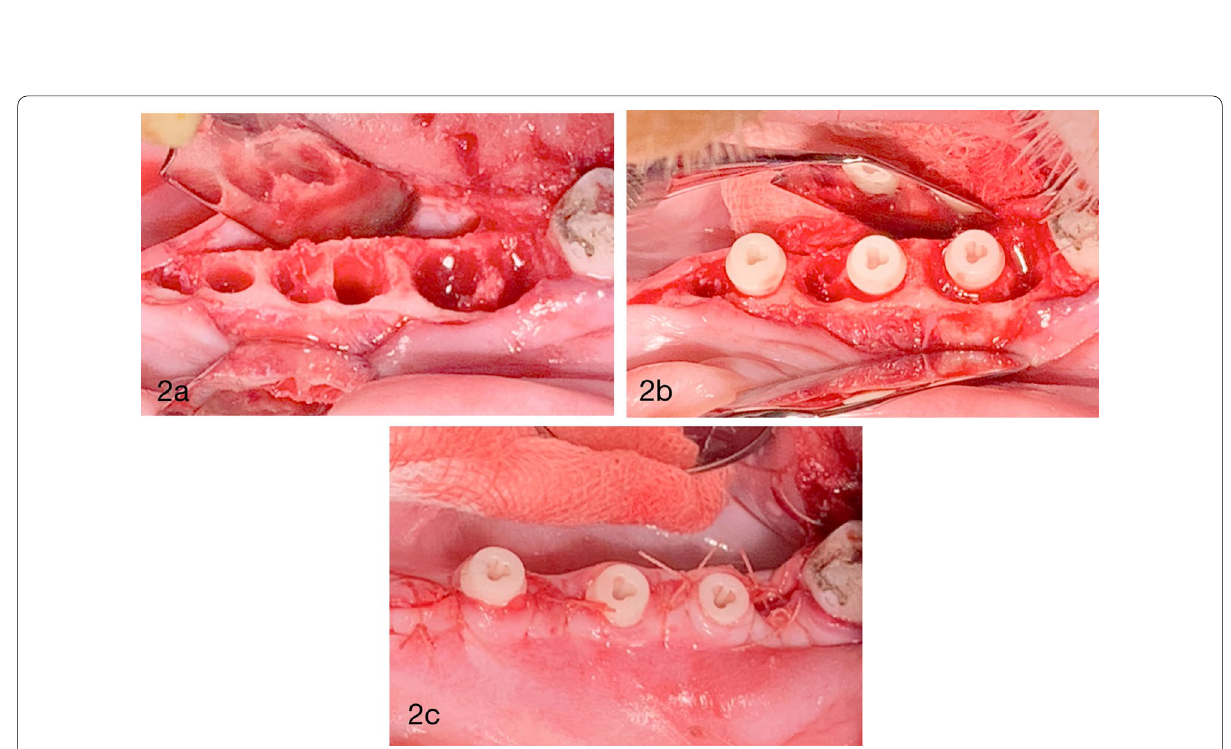
Fig. 2 a. Occlusal view of post extraction morphology. b. Postoperative condition following implant insertion and flap